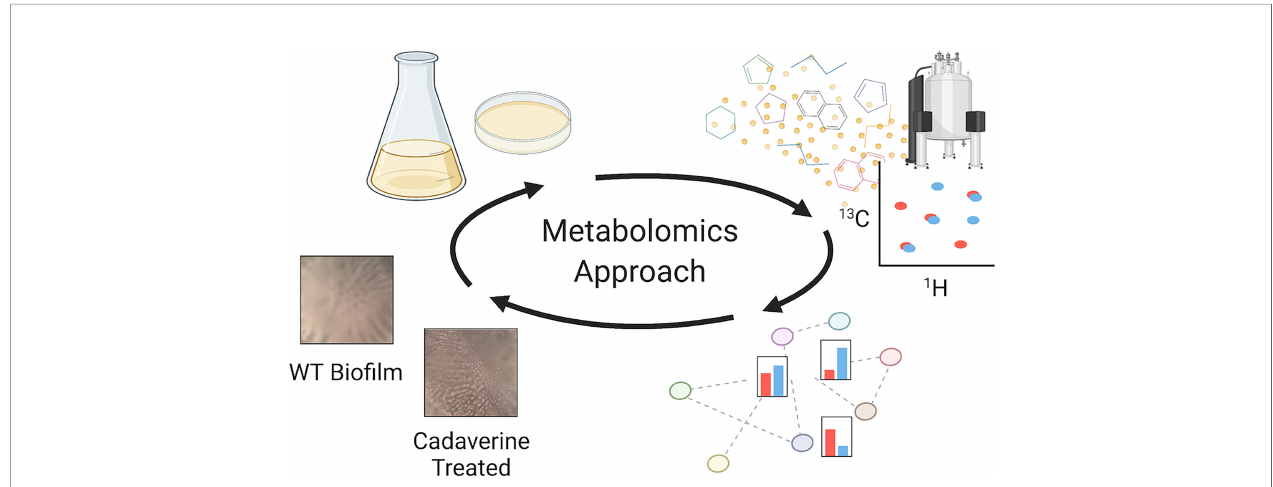
FIGURE 1 | Metabolomics work fl ow to perform untargeted NMR-based metabolomics measurements, identify major metabolite changes, and test the role of the metabolites of interest. From the top left following the arrows: planktonic and bio fi lm PAO1 samples are prepared, and metabolites are extracted and measured by NMR; metabolites are then quanti fi ed and mapped to pathways for a biological interpretation; differentially quanti fi ed metabolites are tested to interpret their role in mode of growth. For example, there are signi fi cant decreases in the cadaverine pathway metabolites in bio fi lm compared to planktonic. When cadaverine is supplemented to the culture, bio fi lm accumulation is signi fi cantly reduced and morphology is altered. Created with